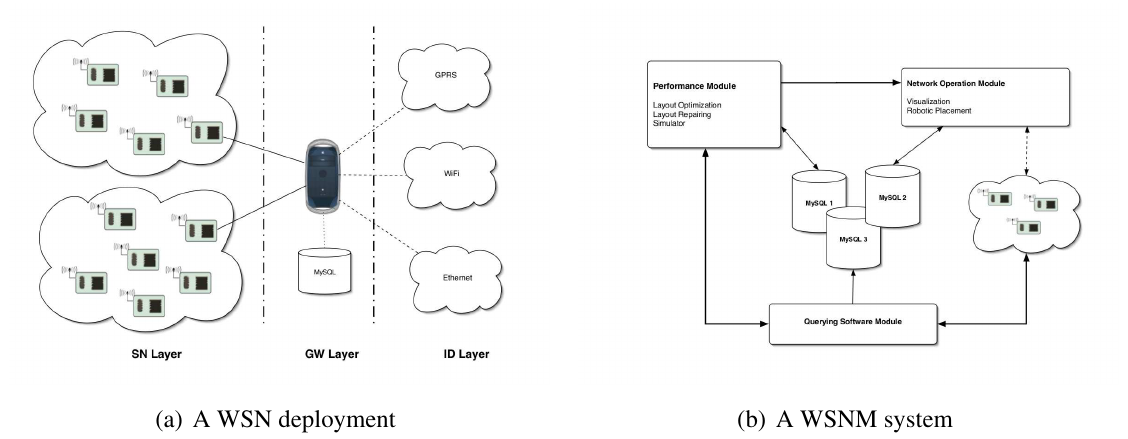
Figure 1. Wireless sensor